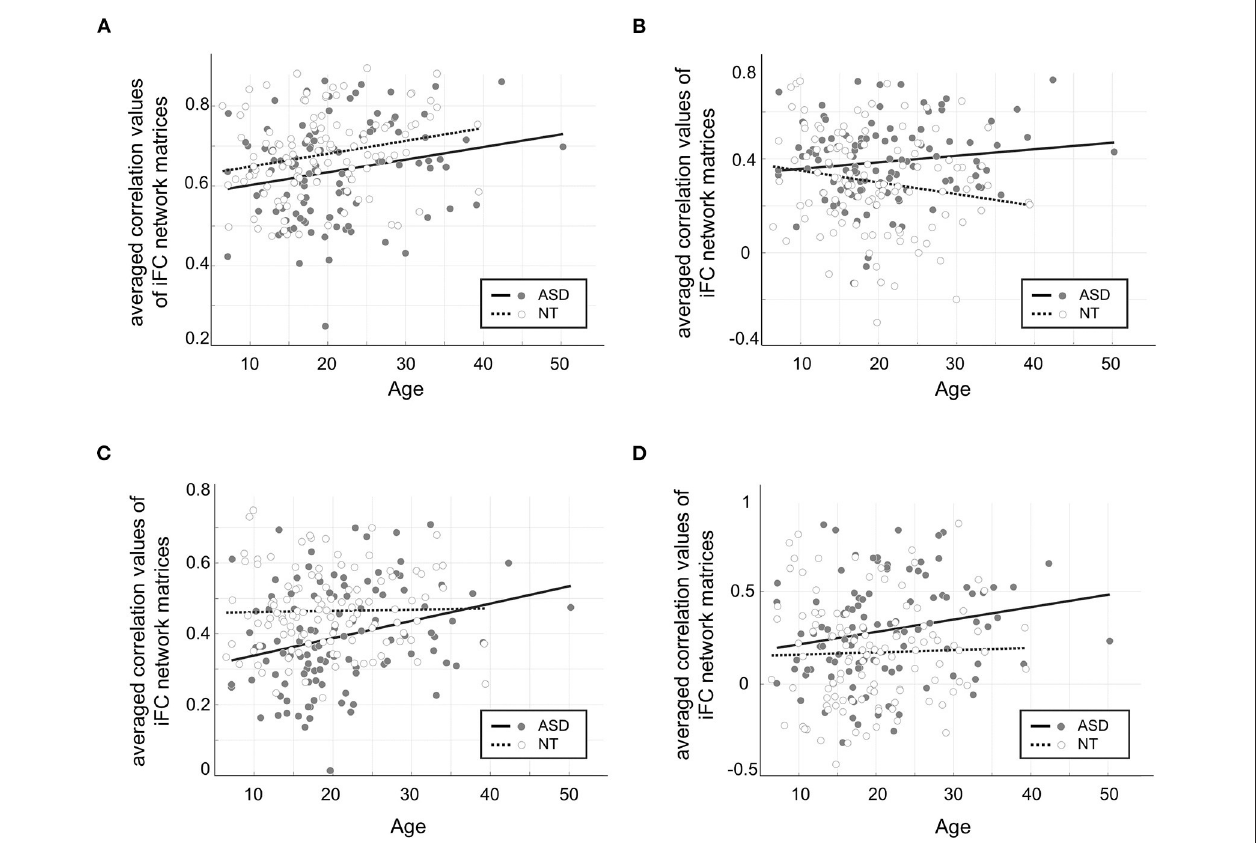
FIGURE 4 | Age by group interaction effects in the connectivities showing significant group differences in previous seed-based analyses. (A) Hypoconnectivity among low-level sensory/motor regions in ASD compared to NT was consistently observed across age, but there was no significant interaction effect ( F = 0.03, p = 0.85). (B) Hyperconnectivity among low-level cortico-subcortical network connections became increasingly more severe across age in ASD, revealing a significant interaction effect ( F = 5.27, p = 0.02). (C) Hypoconnectivity among high-order networks in ASD showed a less severe pattern with age, resulting in a significant interaction effect ( F = 4.04, p < 0.05) (D) Hyperconnectivity among high-order networks in ASD showed an increasing age-dependent trend, yet no significant interaction effect ( F = 1.27, p =